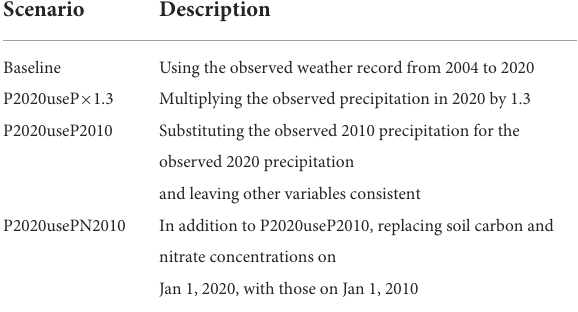
TABLE 2 Numerical scenarios used in this study to explore the impacts of drought-to-flood transition on nitrogen loss in Section